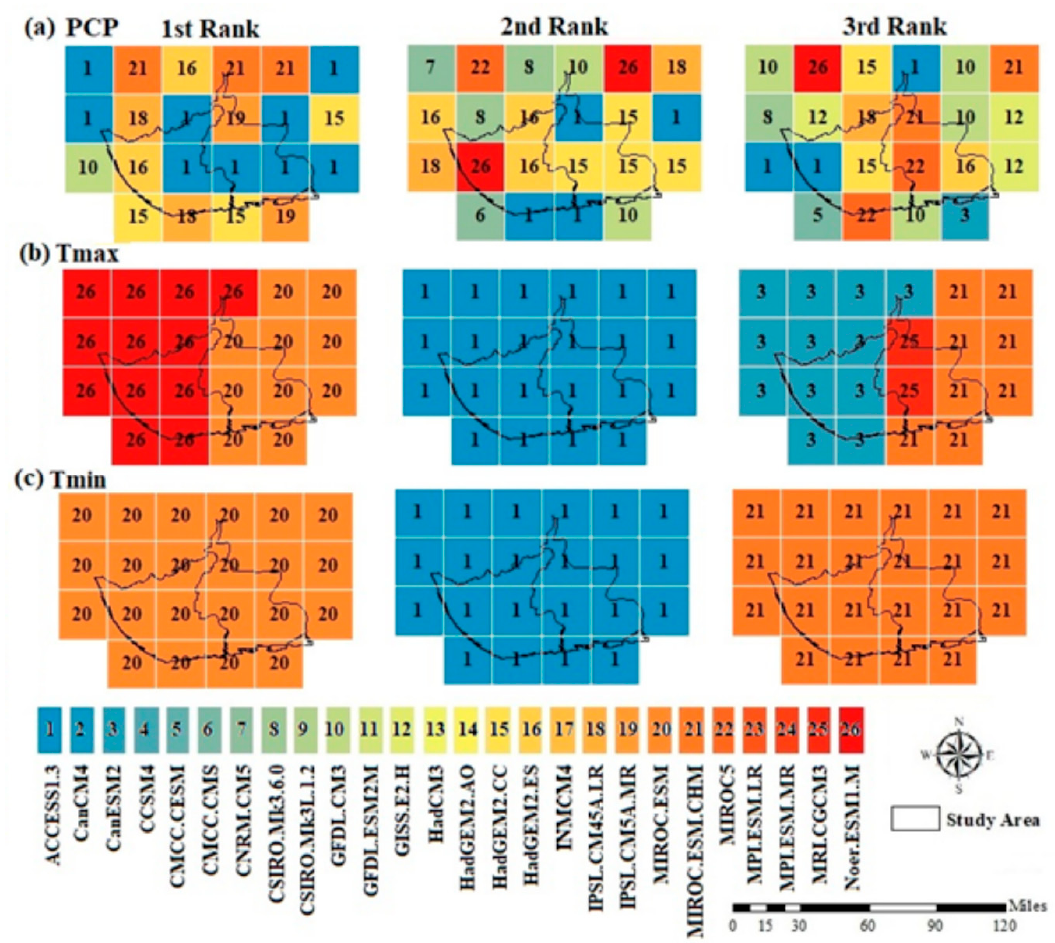
Figure 2. The spatial distribution of GCMs ranked best, second-best, and third-best position using a symmetrical uncertainty filter at different gird points for Prcp, Tmax, and Tmin over the Niger Delta.